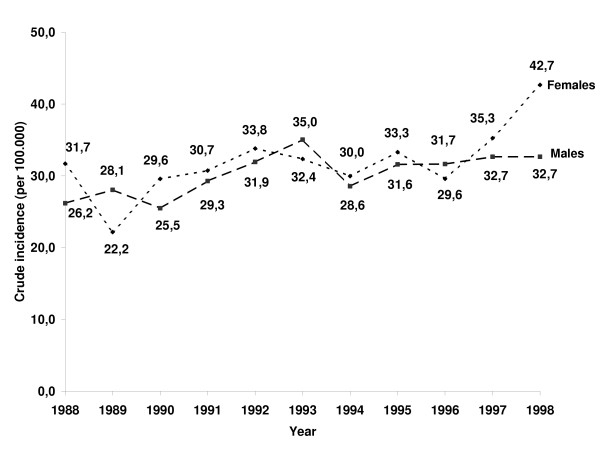
Time trend of the crude incidence rates of the invasive colon adenocarcinomas (n = 1379) by gender; 1988–1998.